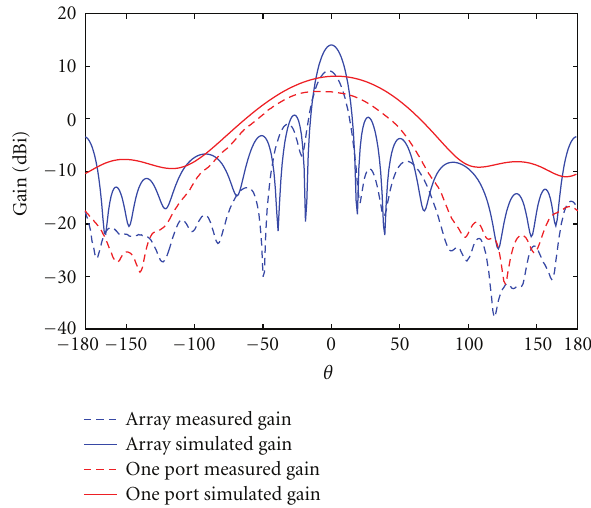
Figure 13: Array on Azzurri: gain pattern at 2.45 GHz, in the elevation plane ( xz -plane), simulation versus measurement of the entire array and of one single patch.